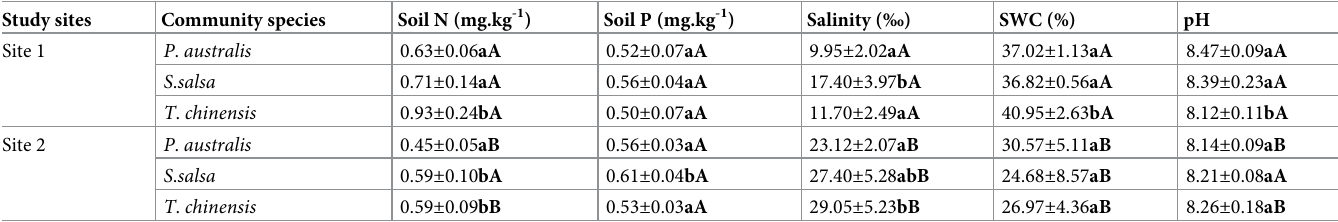
Fig 7. Relationships between LMA and photosynthetic nutrient use efficiency of halophytic plant communities. (a) LMA and PNUE (equation for site 1: y = 10339x − 1.625 , R 2 = 0.909, P < 0.001; equation for site 2: y = 204171x − 2.036 , R 2 = 0.923, P < 0.001; equation for all species: y = 24214x − 1.719 , R 2 = 0.805, P < 0.001); (b) LMA and PPUE (equation for site 1: y = 118828x − 1.54 , R 2 = 0.849, P < 0.001; equation for site 2: y = 45843x − 1.36 , R 2 = 0.812, P < 0.001; equation for all species: y = 74475x − 1.451 , R 2 = 0.832, P < 0.001). https://doi.org/10.1371/journal.pone.0229047.g007 salsa than in the communities of P . australis and T . chinensis (Table 1, P < 0.05). For soil P, the differences among the three communities were not significant (Table 1, P > 0.05). Table 1. Soil physicochemical properties of halophytic plant communities in two